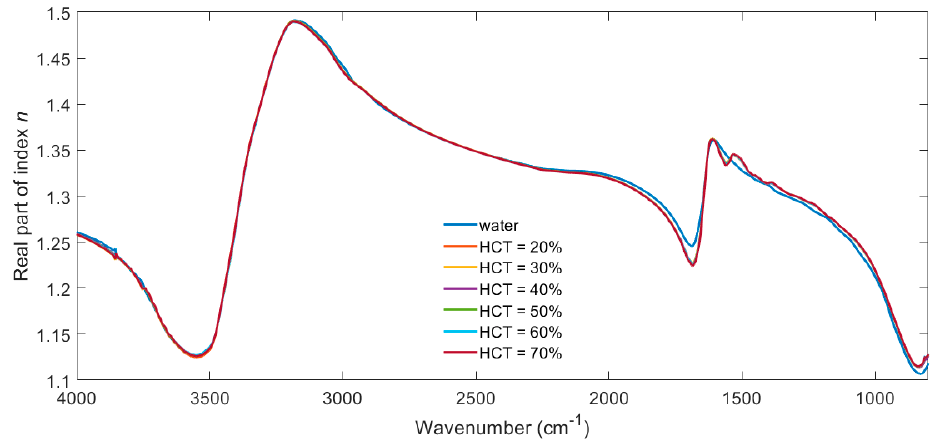
Figure 4. Real part of refractive index spectra n( λ ) for water and whole blood with haematocrit in the range of 20–70%.